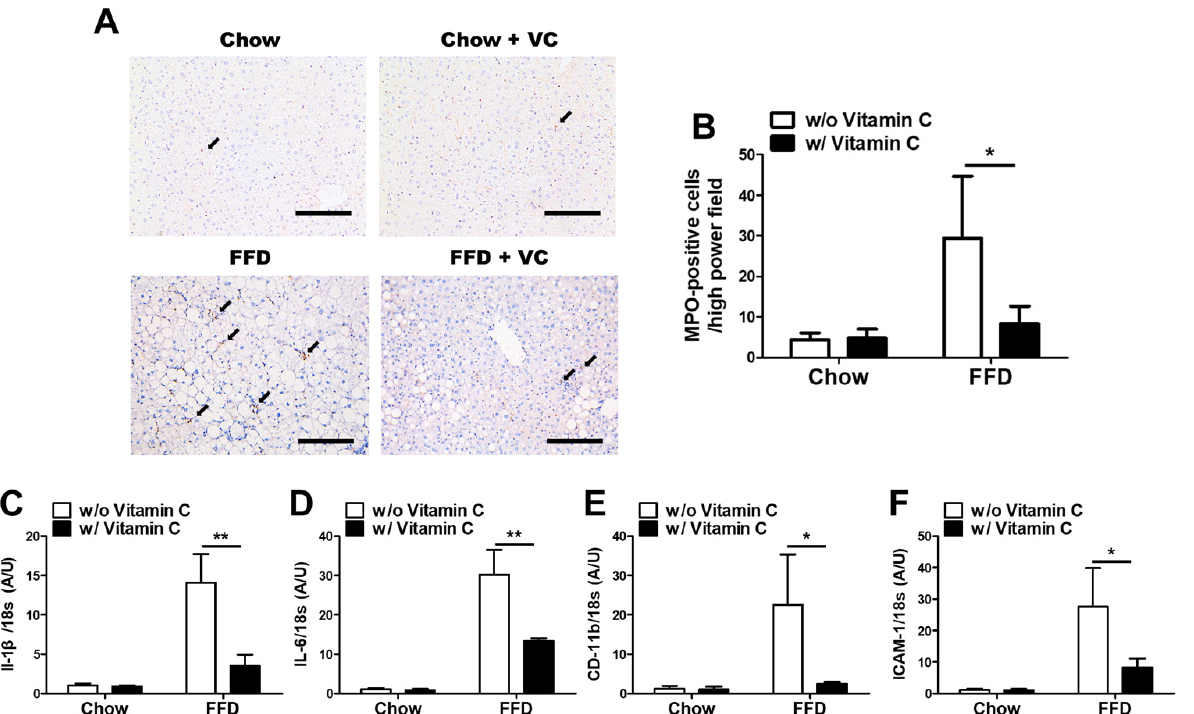
Figure 5. Effects of the mega-dose vitamin C treatment on the NASH-mediated inflammatory responses. ( A ) Representative images of MPO immunohistochemistry results in liver. The MPO positive cells were indicated by arrow; and ( B ) number of MPO positive cells in high power field; ( C ) Quantitative real time PCR analysis for IL-1 β ; ( D ) IL-6; ( E ) CD-11b; and ( F ) ICAM-1. Data were normalized to mRNA expression levels of 18s. Data are expressed as means ± SD per group ( B – F ). n = 5 mice in each group ( B – F ). * p < 0.05, ** p < 0.01. Scale bars = 100 µ m ( A ) Original magnification, 200 × ( A